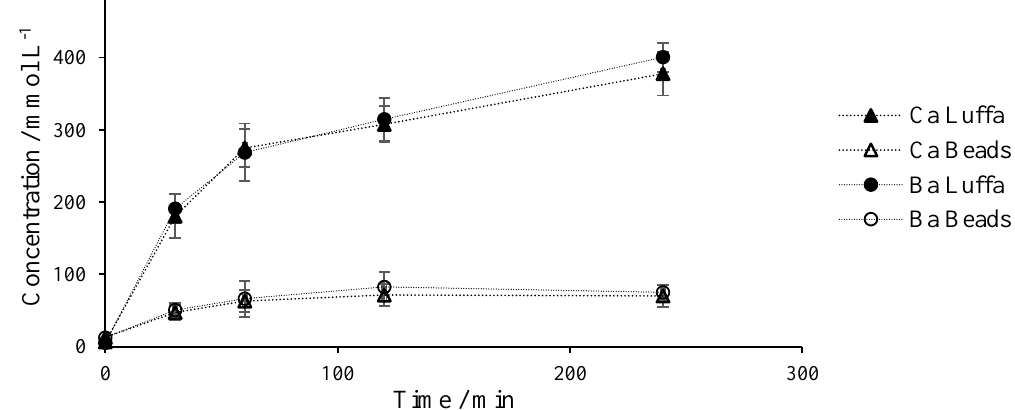
Figure 9. Time course of lactol formation by immobilized DERA on Luffa or in beads, 5 mL of final volume, 0.1 M of TEOA buffer with pH 7.5, 70 mL of DMSO, 0.5 M of 2 , 1.0 M of 1 , 32.5 °C, 100 mg of freeze-dried E. coli cells hosting DERA, 2% ( w / v ) Na-alginate in 0.9% ( w / v ) NaCl solution, cross-linking induced by Ca 2+ or Ba 2+ , 2% ( w / v ), respectively.